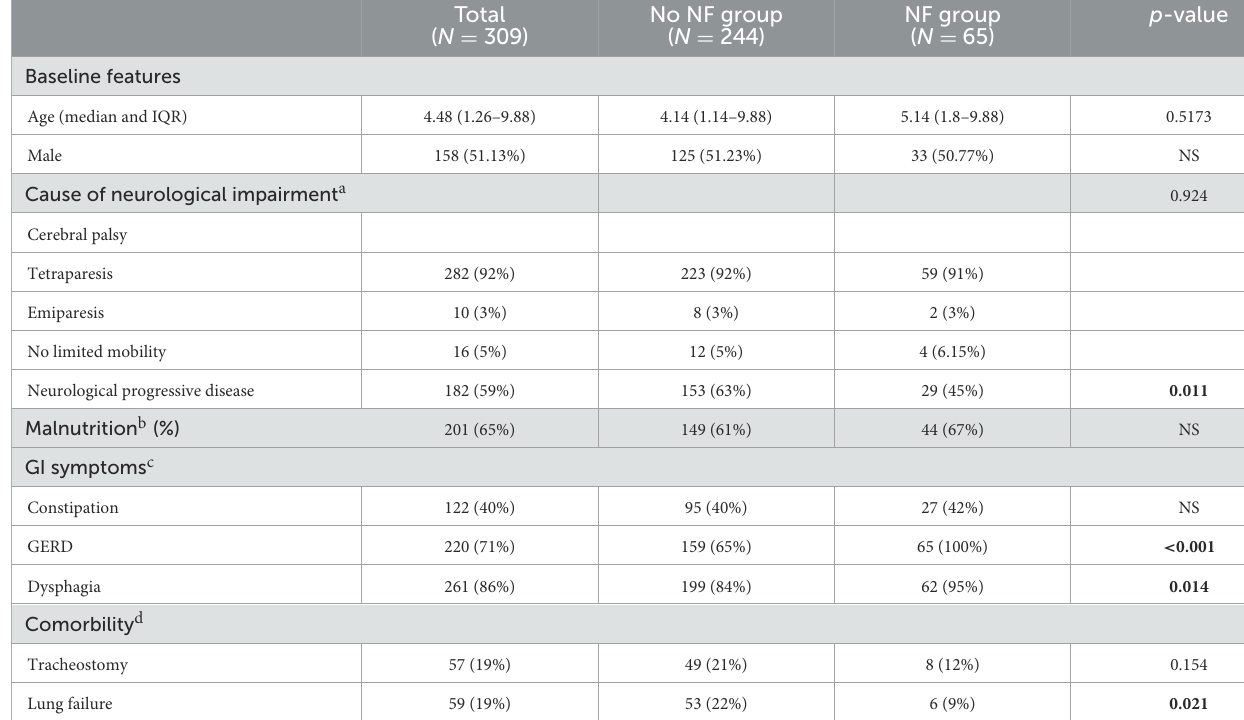
TABLE 1 Clinical characteristics of the study population; all data were collected at enrollment.